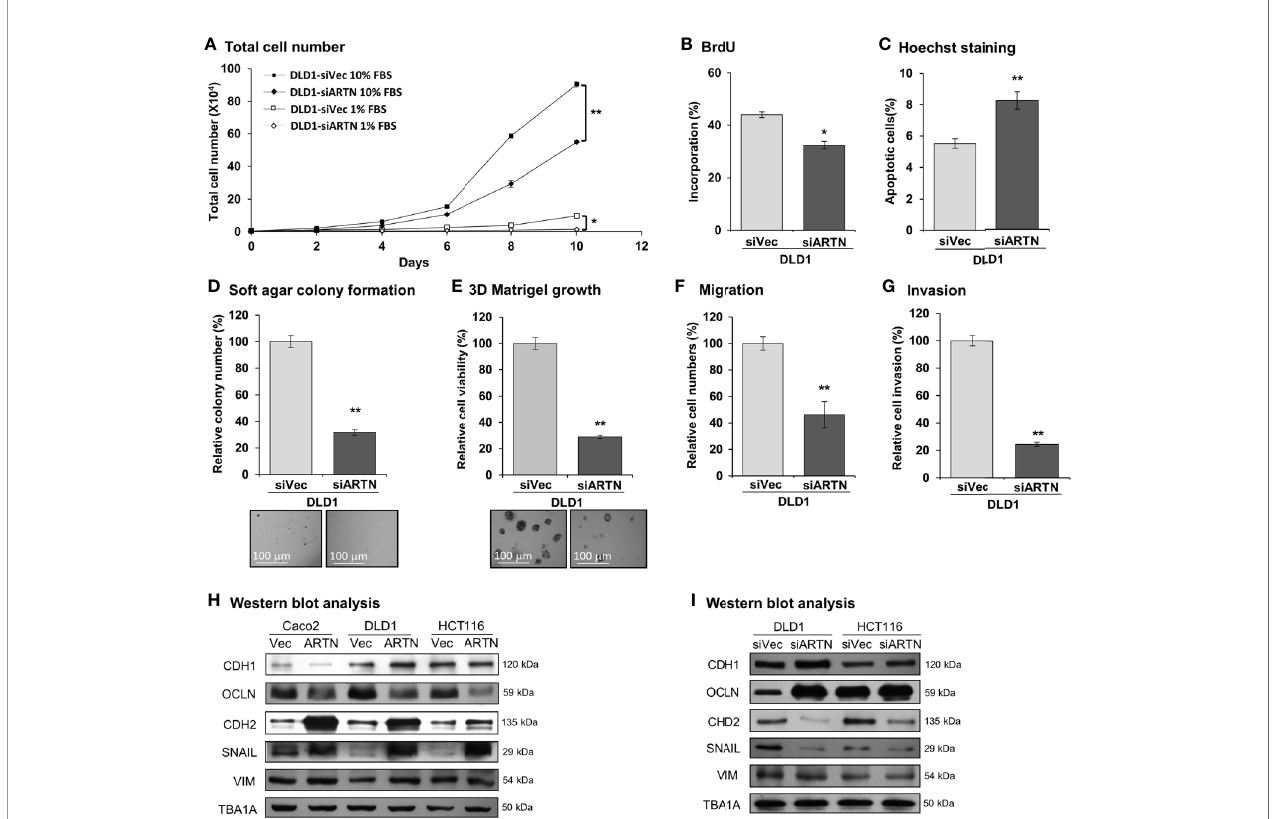
FIGURE 3 | Depletion of ARTN inhibits oncogenic behaviors of CRC cells. (A) Total cell number of DLD1-psilencer and DLD1-siARTN cells under normal culture condition (medium with 10%FBS) or serum deprivation conditions (medium with 1% FBS). (B) BrdU incorporation assay determined S-phase entry of DLD1-psilencer and DLD1-siARTN cells cultured under serum deprivation conditions for 24 hours. (C) Hoechst 33258 staining determined apoptotic nuclei percentages of DLD1- psilencer and DLD1-siARTN cells cultured under serum deprivation condition for 24 hours. (D) Soft agar colony formation of DLD1-psilencer and DLD1-siARTN cells. The colony numbers were counted and presented as relative percentage change. (E) 3D Matrigel growth of DLD1-psilencer and DLD1-siARTN cells. Cell viability was measured by AlamarBlue assay and presented as the relative percentage changes. (F) Transwell migration assay with DLD1-psilencer and DLD1-siARTN cells. (G) Transwell invasion assay with DLD1-psilencer and DLD1-siARTN cells. (H, I) , Western blot analysis for the expression of epithelial and mesenchymal cell markers and EMT regulator SNAIL in the stable cell lines with forced expression (H) or depletion (I) of endogenous ARTN. * p < 0.05, ** p <